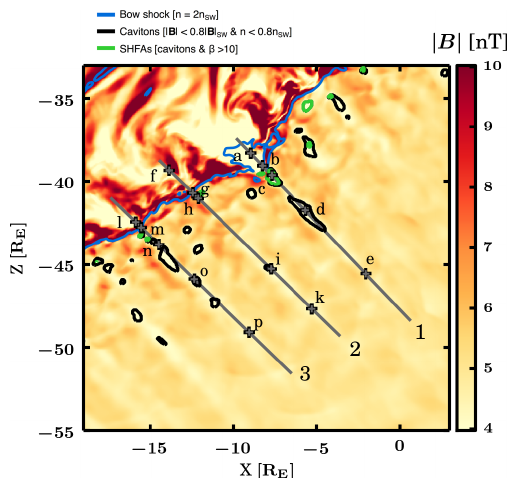
Figure 4. The local region around the magnetosheath cavity, show- ing the extent of bow shock erosion at time T 3 = 1350s. The figure extents are 10 × 10 R E with the colour scale showing proton num- ber density on a logarithmic scale. The contours represent the bow shock (blue), cavitons (black), and SHFAs (green).